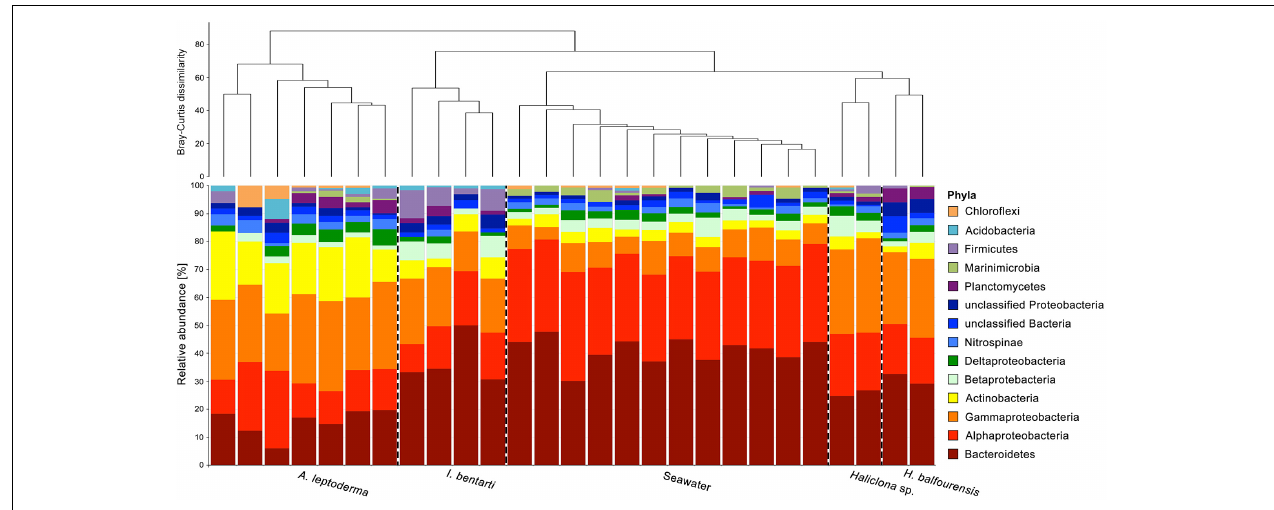
FIGURE 2 | Relative abundance of the most abundant prokaryotic phyla, with Proteobacteria divided into classes, based on 16S rRNA gene sequences obtained from all individual sponge specimens. Only the most abundant taxa are shown. Rare phyla, below 0.5% among all samples, were excluded. The dendrogram is based on Bray–Curtis dissimilarities (relative abundances of